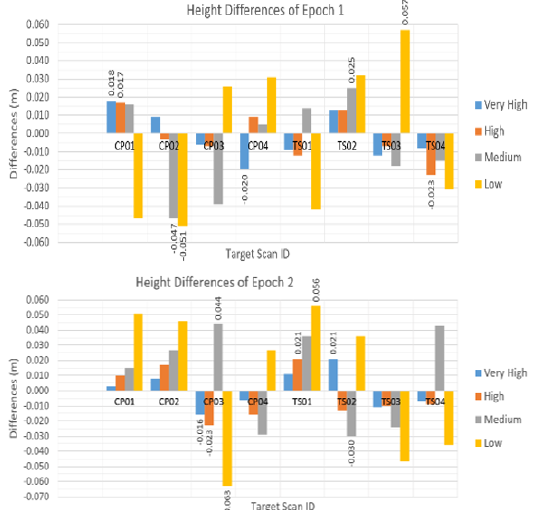
Figure 47. Height coordinates differences between manually point picking and automatically computed by ScanMaster software (epoch 1 and 2)